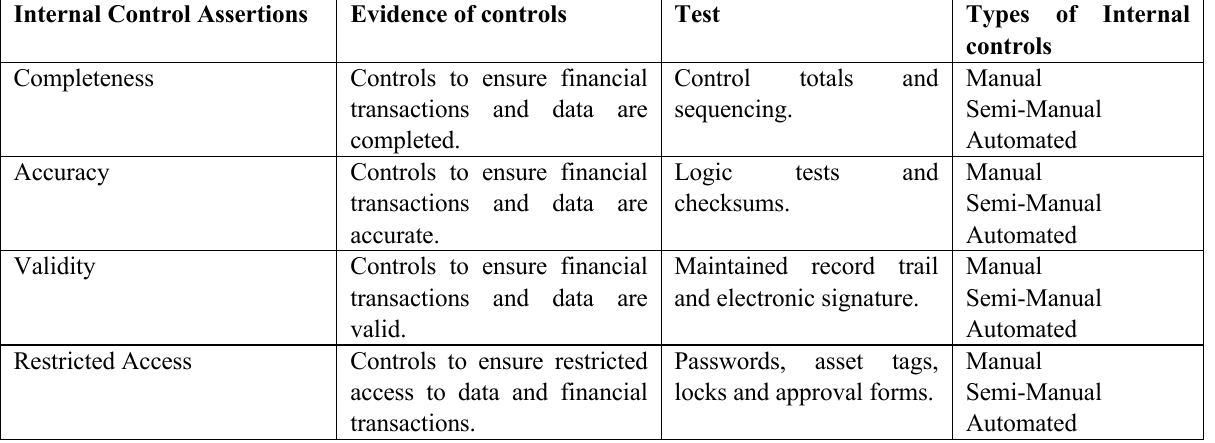
Table 3. Internal Control Assertions: